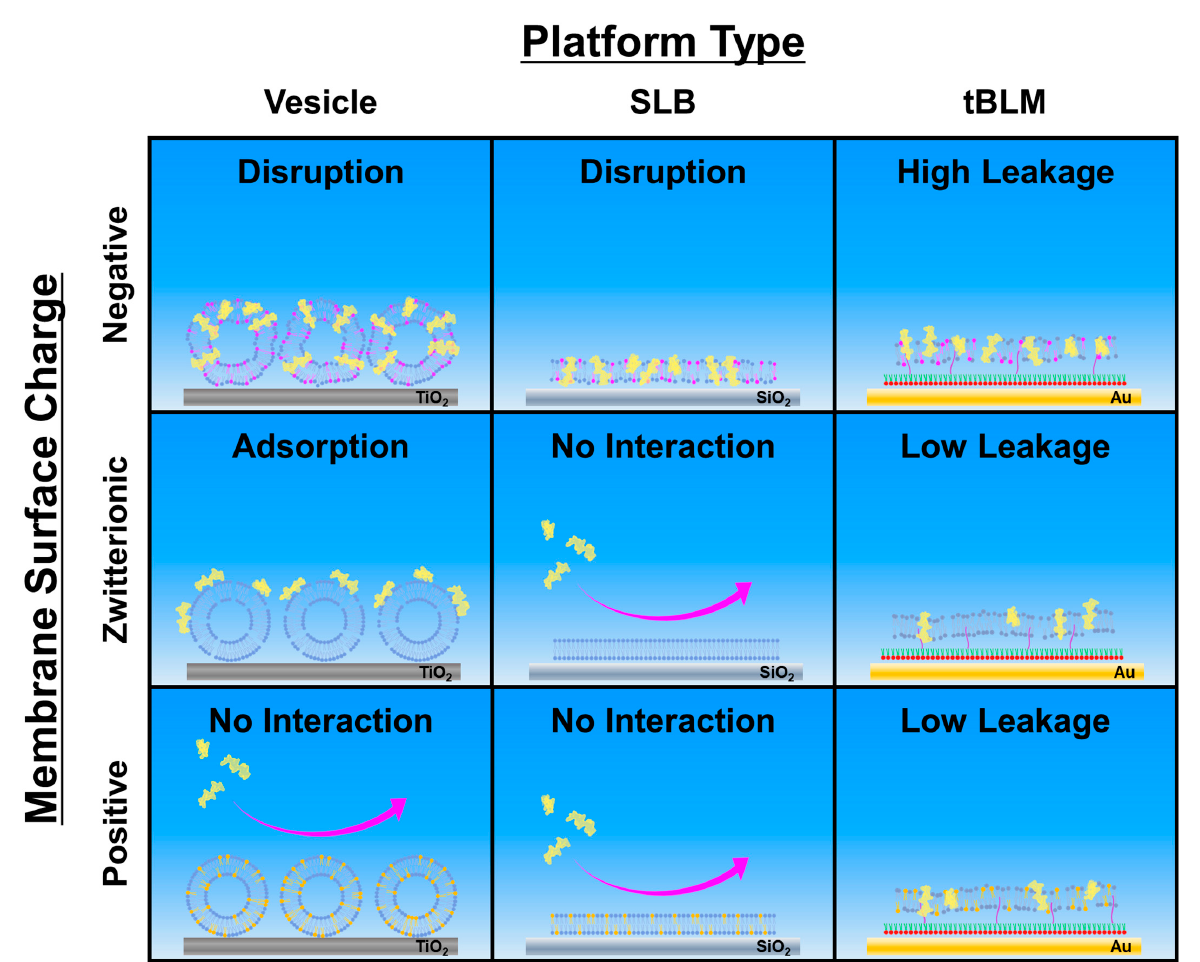
Figure 7. Schematic summary of LTX-315 peptide interactions with lipid membranes and relevant mechanistic factors. The two main tested parameters were membrane surface charge and nanoar- chitecture. In general, LTX-315 preferentially disrupts negatively charged membranes and